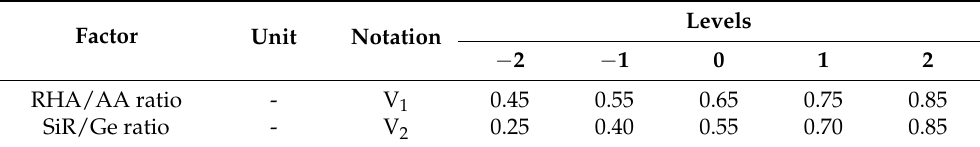
Table 2. Factors and